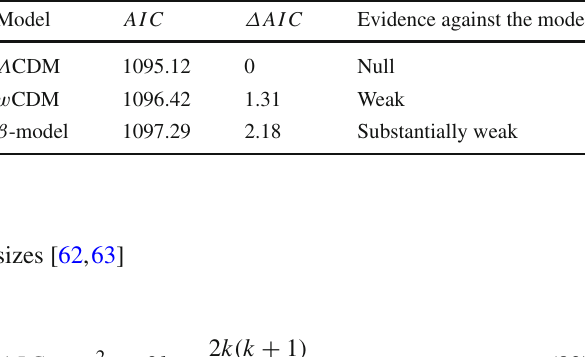
Table 4 A summary of the obtained values of AIC for the studied models. The Λ CDM model is adopted as a reference.